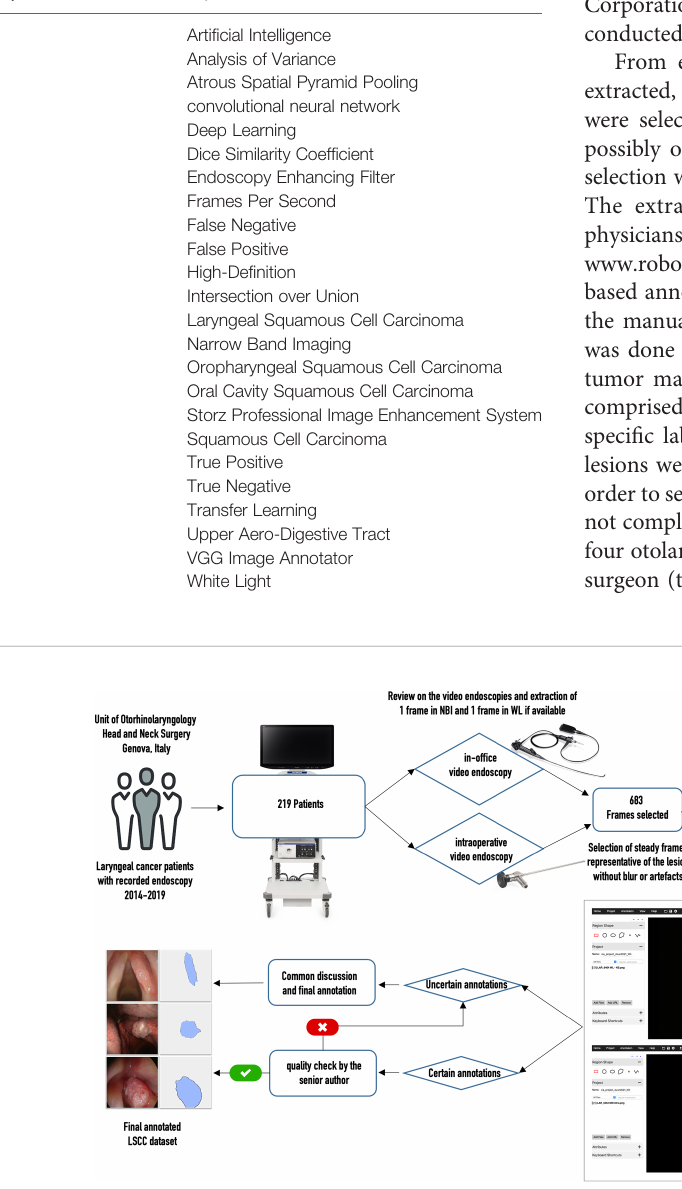
FIGURE 1 | Flow chart of data acquisition for the laryngeal squamous cell carcinoma (LSCC) dataset. WL, white light; NBI, narrow band imaging.